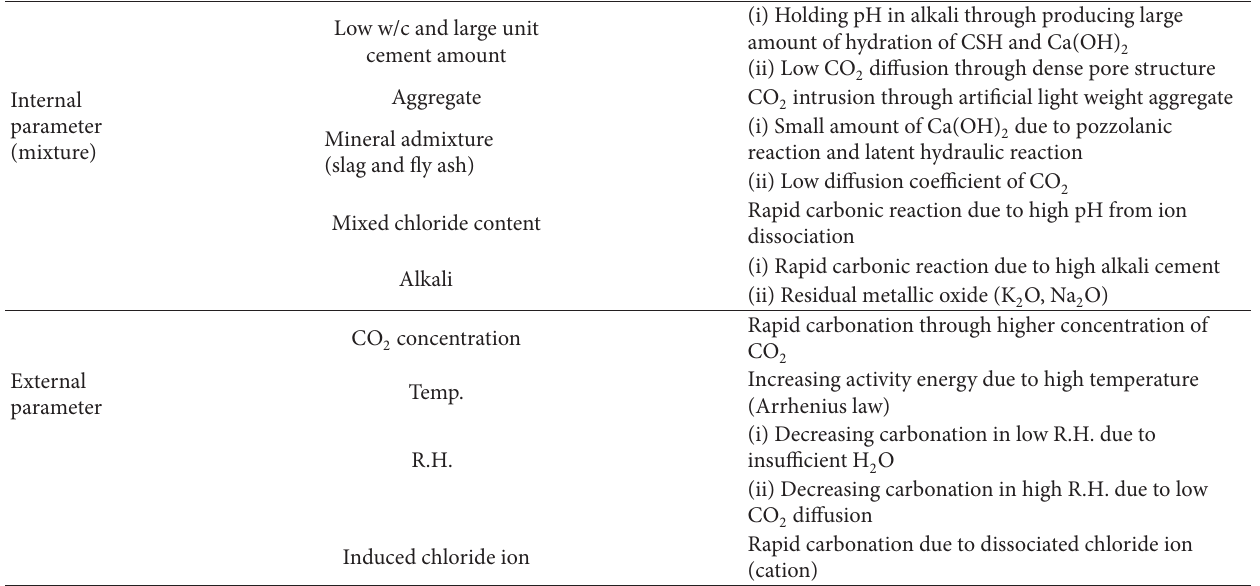
Table 1: Influencing parameter on carbonation behavior.